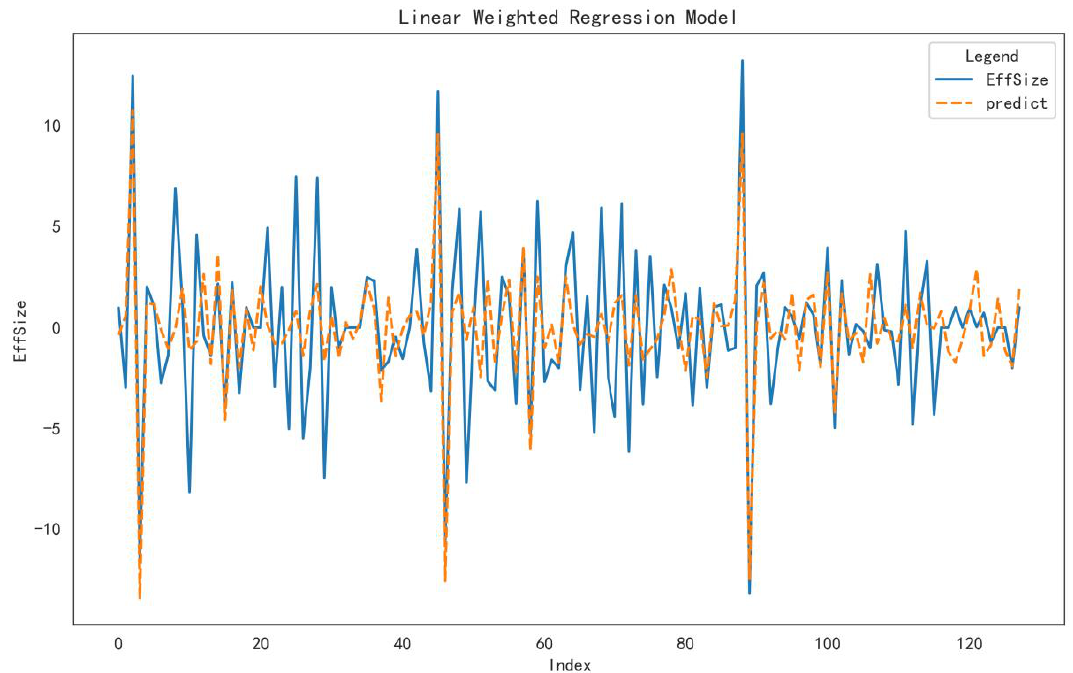
Figure 9. Linear weighted regression model. Table 3. Regression parameters.